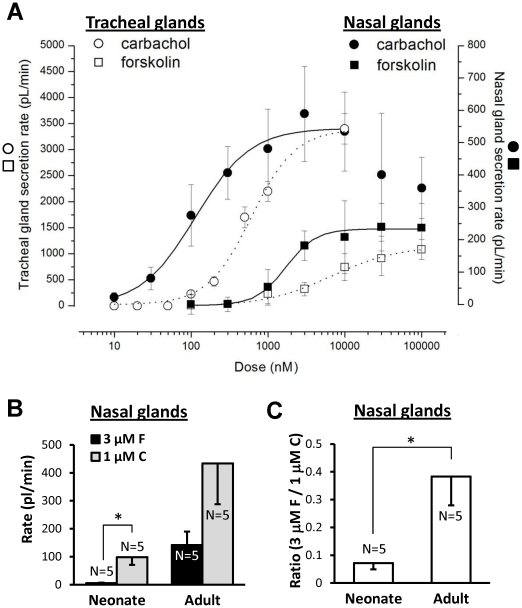
Agonist sensitivities.
A, Nasal glands are more sensitive than tracheal glands to both carbachol and forskolin. Dose-response plots for carbachol (circles) and forskolin (square) in nasal glands (solid line, closed symbols) and tracheal glands (dotted line, open symbols) of adult pigs. Tracheal gland responses are plotted on the left Y axis and nasal gland responses on the right Y axis; the two Y axes were adjusted to give overlapping maximal response rates to carbachol. The carbachol dose-response for tracheal glands (dotted line, open circles) is from Choi et al., 2007 [27]. Each point represents average data from 33–80 glands in 3–7 pigs; doses were increased sequentially except for concentrations ≥3 µM forskolin and ≥1 µM carbachol, where single doses were tested in each experiment to avoid desensitization and merging of bubbles. B, nasal gland secretion rates of neonates and adults to carbachol and forskolin (*indicates paired t-test, P<0.02). C, The ratio of secretion rates to forskolin vs. carbachol was significantly greater in adult than in neonatal pigs (t-test, * indicates P<0.02).